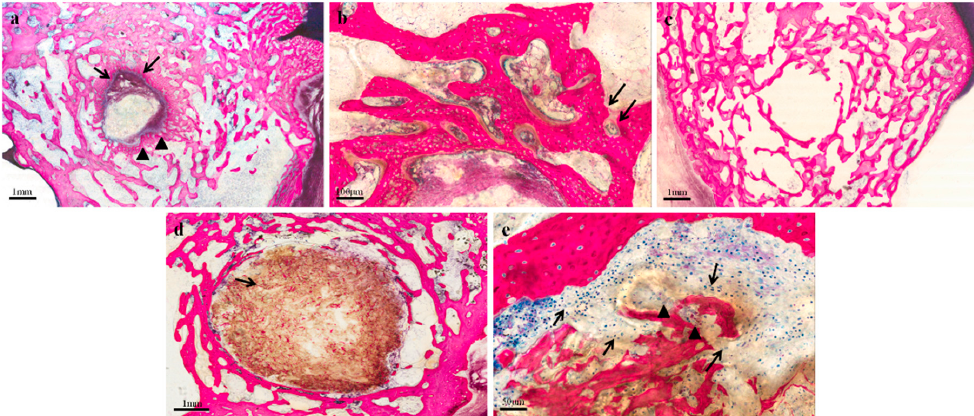
Figure 1. RegenOss ( left panel ) and experimental group ( right panel ) micro-CT sections. Organization of each panel: ( a ) Micro-CT sections of the right leg samples in the axial, sagittal, and coronal planes, scale bar 5 mm; ( b ) Lateral condyle sagittal micro-CT section ( right leg samples ), scale bar 3 mm; ( c ) micro-CT sections of the left leg samples in the axial, sagittal, and coronal planes, scale bar 5 mm; ( d ) lateral condyle sagittal micro-CT section ( left leg samples ), scale bar 3 mm.